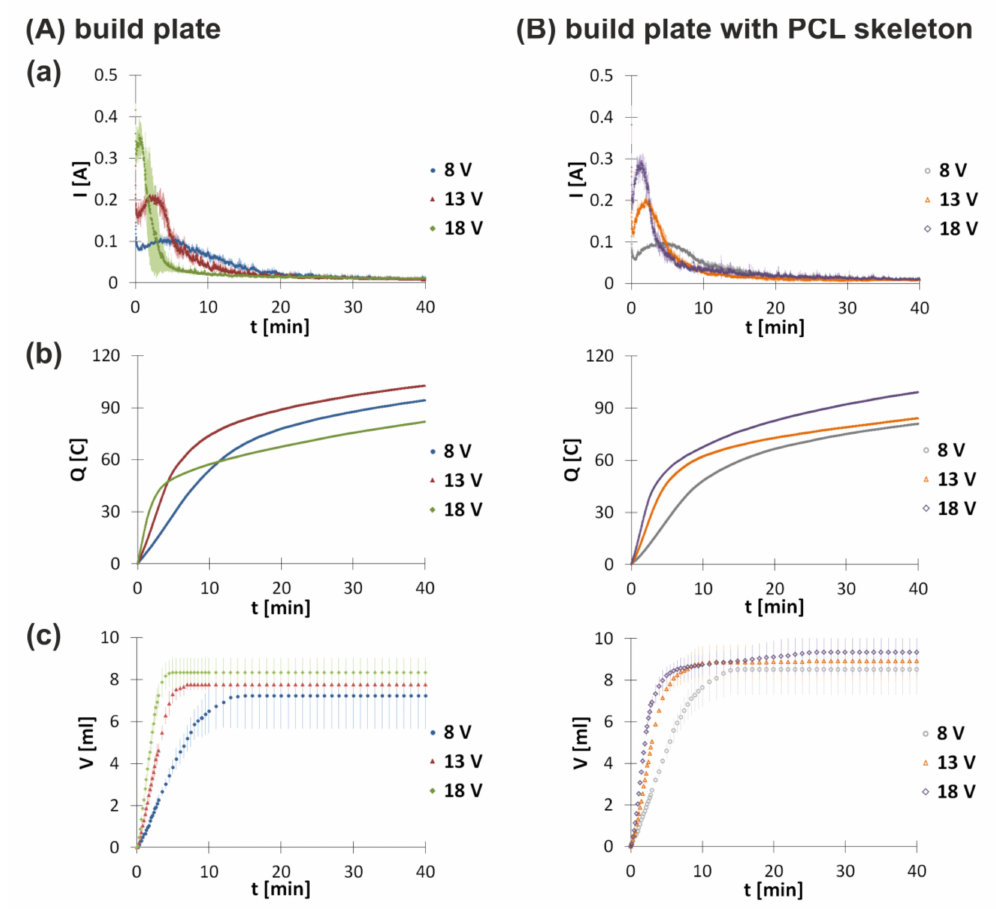
Figure 3. Change in ( a ) amperage, ( b ) charge, and ( c ) gas volume over time for electrodeposition at ( A ) the build plate and ( B ) the build plate with the PCL skeleton initiated at different voltages. Data for amperage and hydrogen volume are shown as the mean ± standard deviation (n =